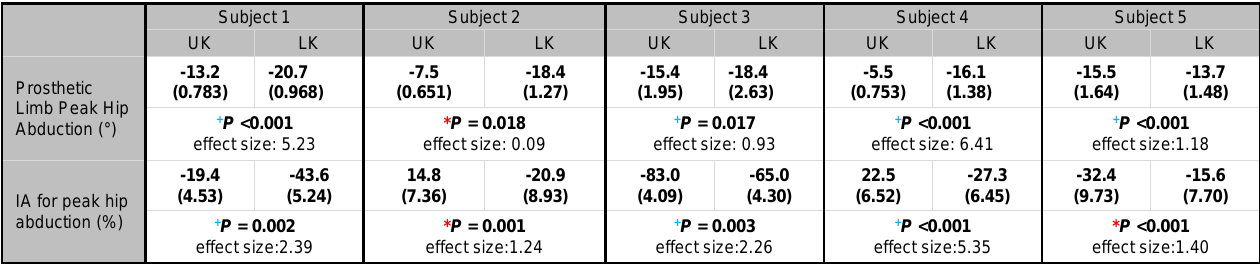
Figure 3: Mean (middle 45 seconds) hip motion in the sagittal (Top) and frontal planes (Bottom) for Subject 1 during the self-selected running speed trial in the unlocked (left) and locked (right) knee conditions. Vertical lines denote toe-off. Table 3: Frontal plane hip kinematics (mean (SD)) during swing phase for select strides for the middle 45 seconds of the three-minute self- selected running speed trial for each subject for each knee condition. Bold values denote statistically significant single-subject differences (0.05 level) between knee conditions. + Denotes a two-tailed paired t-test was conducted (normally distributed data). * Denotes the Wilcoxon signed- rank test was conducted (non-normally distributed data).UK = Unlocked knee, LK = Locked Knee